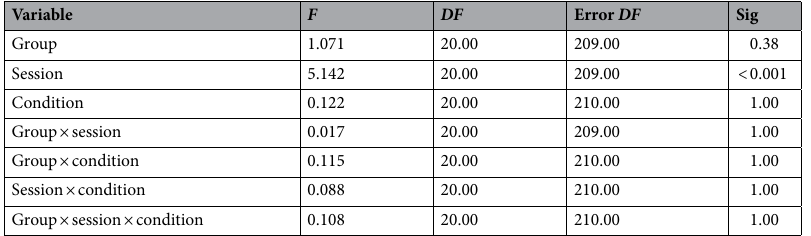
Table 4. MANOVA results. Dependent variable: 20 fNIRS channels for deoxyhemoglobin level, factors: Condition (Resting state vs Grasping Flat vs Grasping Sharp-tip object), and Session (Time-to-contact detection vs Observation-only) and Group (FM patients vs Controls). The Roy square was